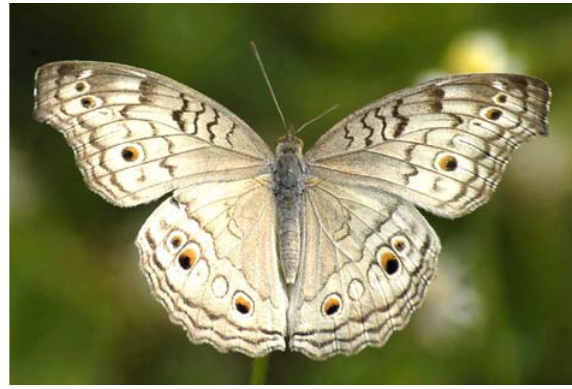
Image 16. Grey Pansy Junonia atlites